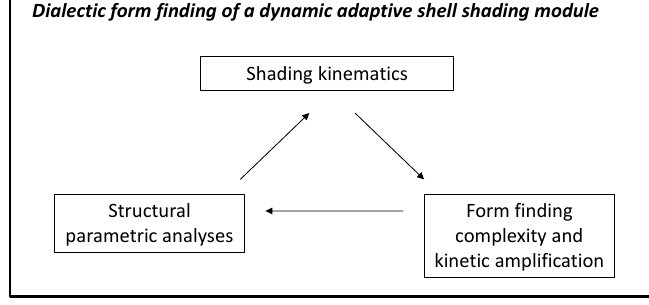
Figure 8. Illustration of the iterative integrated aspect of the dialectic form finding for the dynamic adaptive shell shading module.